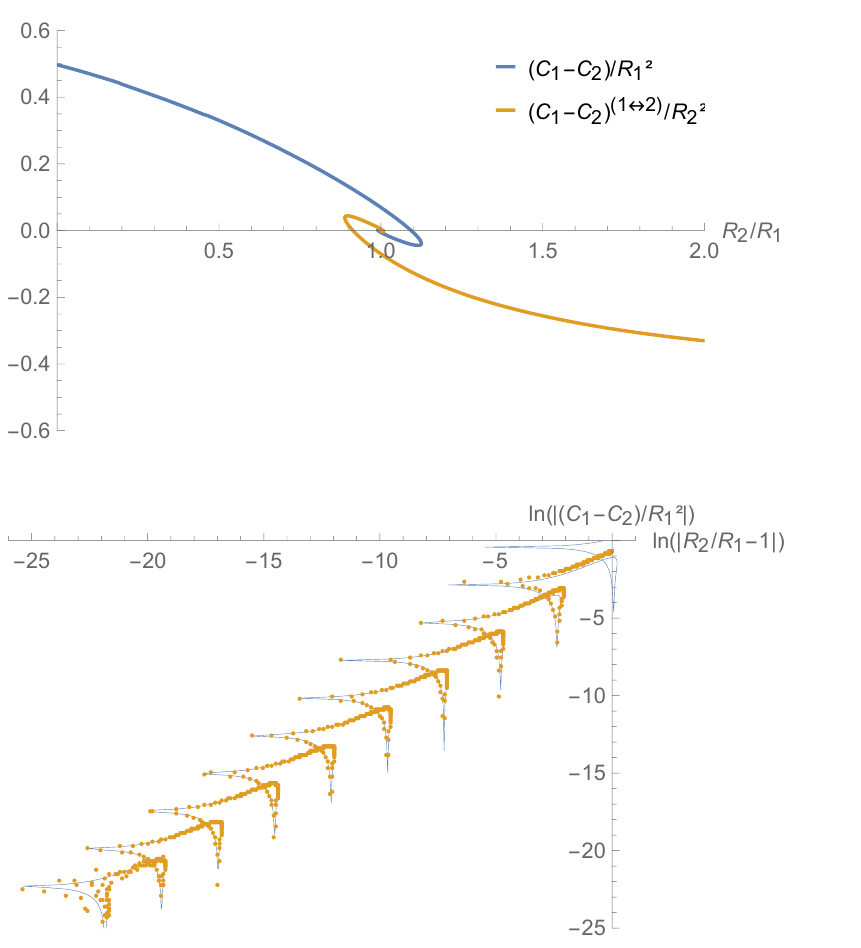
Figure 16 . Top: ( C 1 (cid:0) C 2 ) = R 2 in both the case where the sphere 1 shrinks (blue) and the case 1 where the sphere 2 shrinks (orange) and for ’ 0 = 0 : 1. Bottom: the same plot in the case where 1 shrinks, where we represent the logarithm of the distance to the center of the spiral with coordinates (1 ; 0) for each quantity. The orange dots are given by numerical computation while the blue curve is the (cid:12)t found in